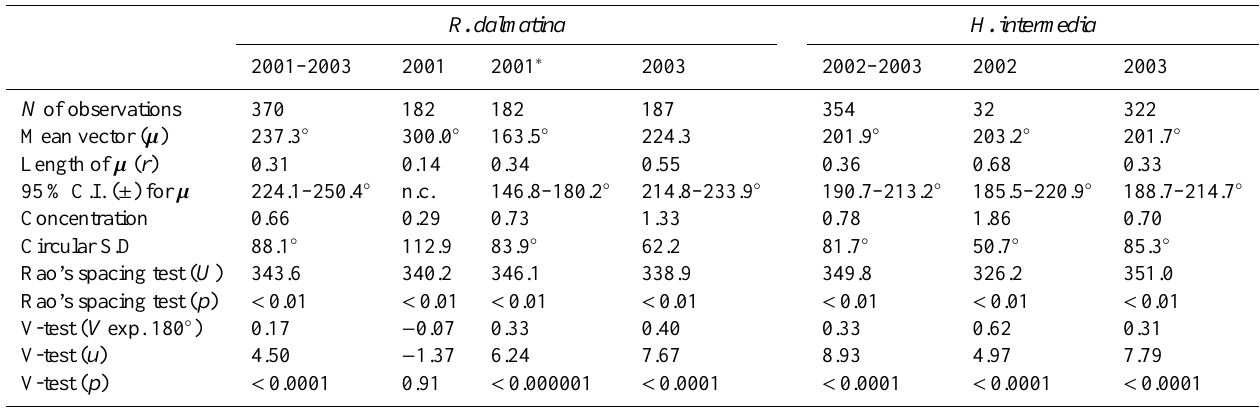
Table 1. Synopsis of the circular statistics for the clutch distribution in two species of amphibians at a locality in Mediterranean Central Italy. For each species yearly and pooled data are reported. The statistical tests refer to whether or not clutches are laid uniformly over the lunar cycle (Rao spacing test) and whether or not clutch distribution have a mean angle (expected mean 180 ◦ ) (V-test) (Batschelet, 1981). For Rana dalmatina , the column 2001 ∗ showed the analysis taking into consideration also the cloud cover (see methods). R. dalmatina